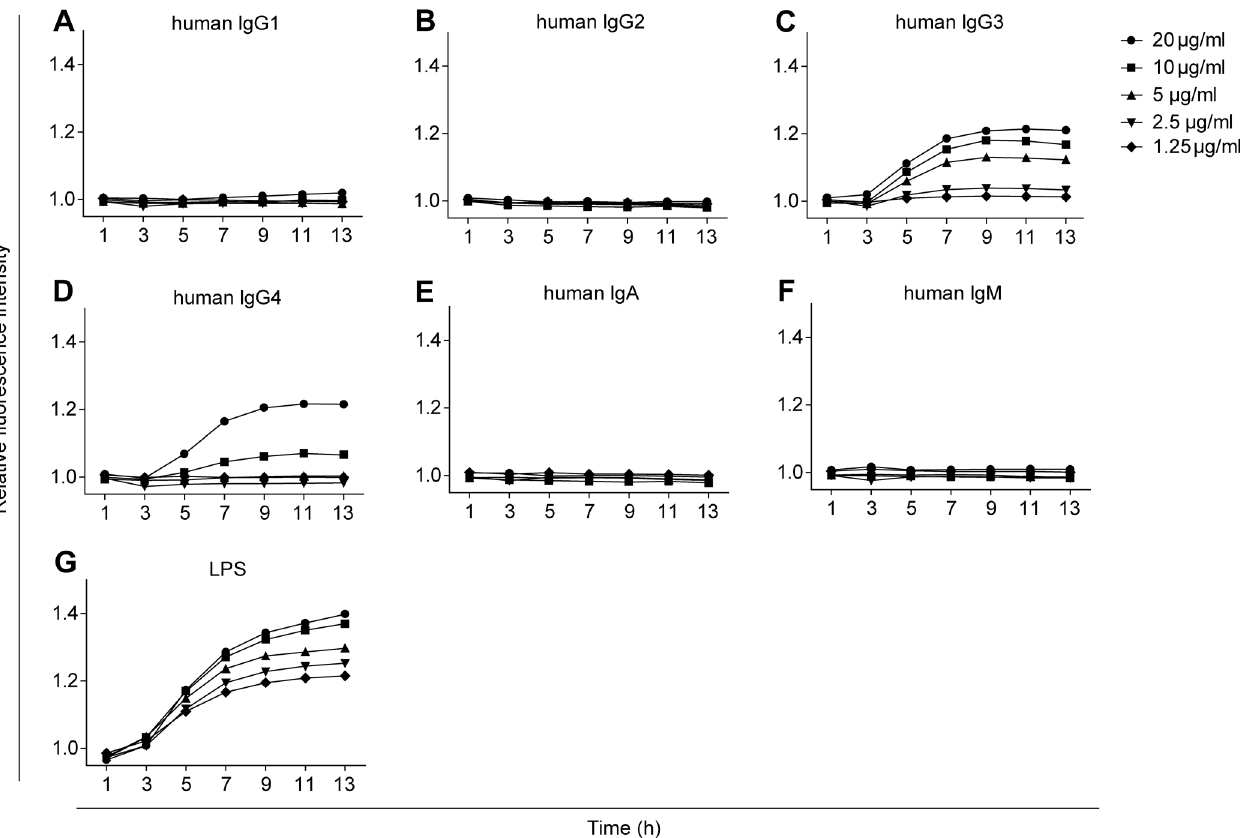
Fig 3. Time- and dose-dependent activation of U937-NF- κ B cells. The activation of U937-NF- κ B cells was screened on plates coated with BSA, human IgG1, IgG2, IgG3, IgG4, IgA, or IgM in two-fold serial dilution from 20 μ g/ml to 1.25 μ g/ml concentration. Following a one hour adhesion period, the cells were imaged for 12 hours by HCS (A-F). The results were normalized to the fluorescence intensities of cells measured on BSA coat. Soluble form of LPS served as positive control (G).